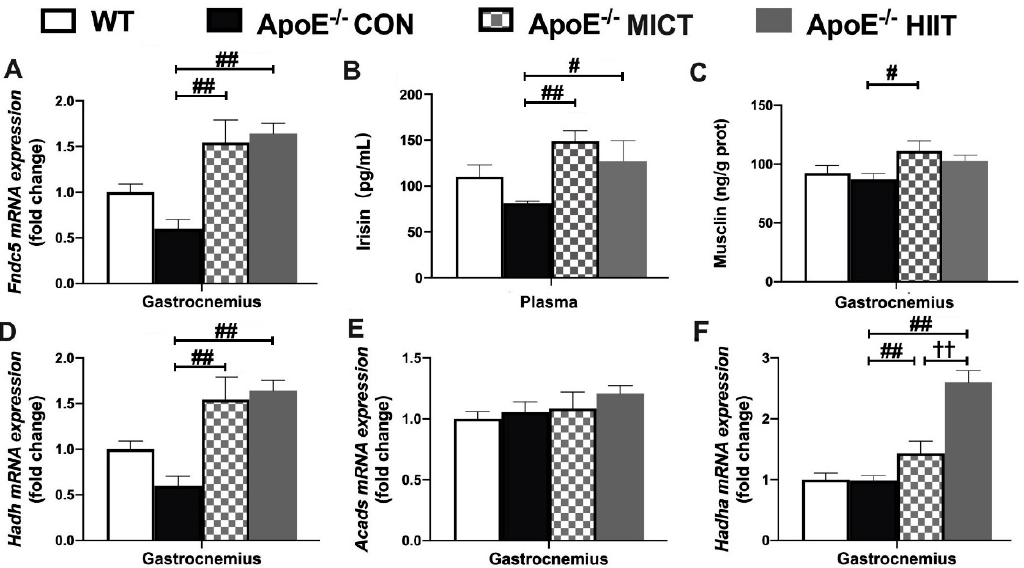
Figure 6. Effects of HIIT and MICT on the mRNA expression of Fndc5 ( A ), Hadh, Acads, and Hadha ( D – F ), and musclin level ( C ) in the gastrocnemius as well as plasma irisin level ( B ) of WT and ApoE KO mice with HFD. Values are displayed as the mean ± SEM (n = 10/group). # p < 0.05 vs. ApoE -/- CON; ## p < 0.01 vs. ApoE -/- CON; †† p < 0.01 vs. ApoE -/- MICT.